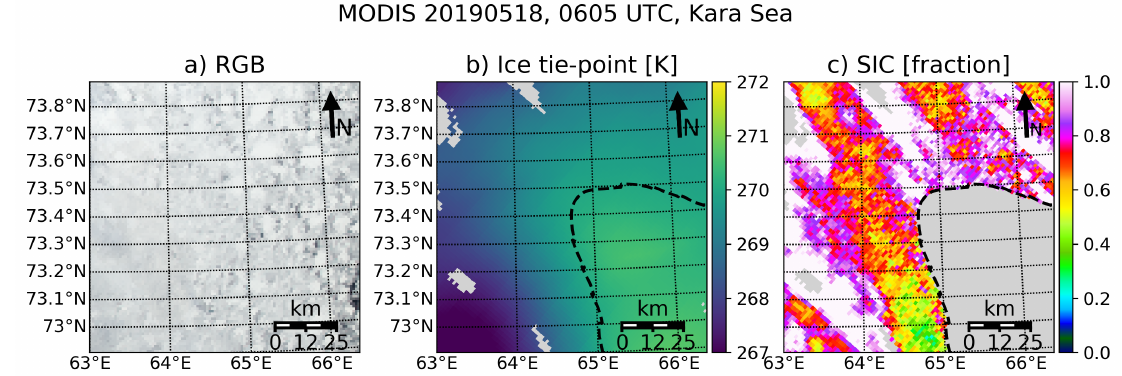
Figure 10. ( a ) MODIS RGB image of the scene in Figure 9g. ( b ) Ice tie-point of the MODIS SIC. The dashed line marks the 270K threshold above which no SIC retrieval is performed. ( c ) MODIS SIC as in Figure